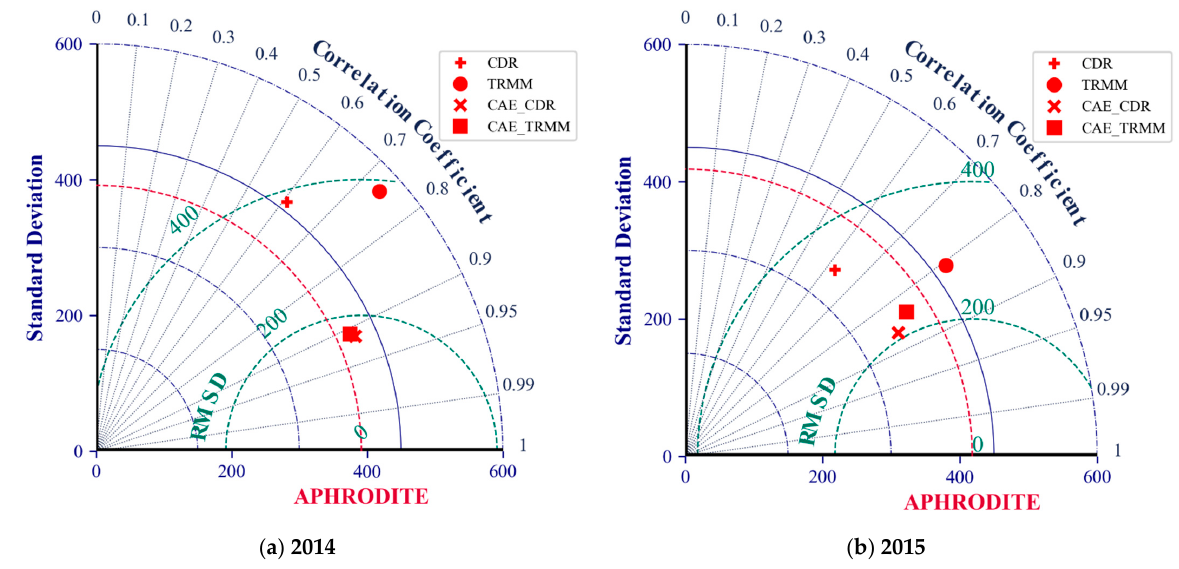
Figure 7. Taylor diagram presents quantitative information of three statistical indicators of rainfall products compared with reference data—APHRODITE product.